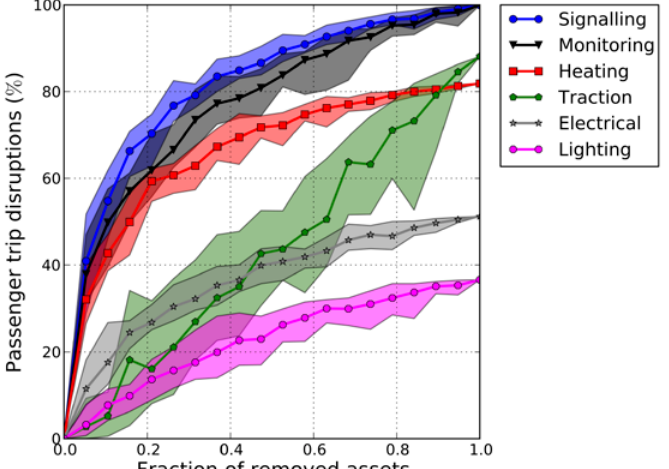
Figure 7. Vulnerability of the railway network due to random failures of different type of functional